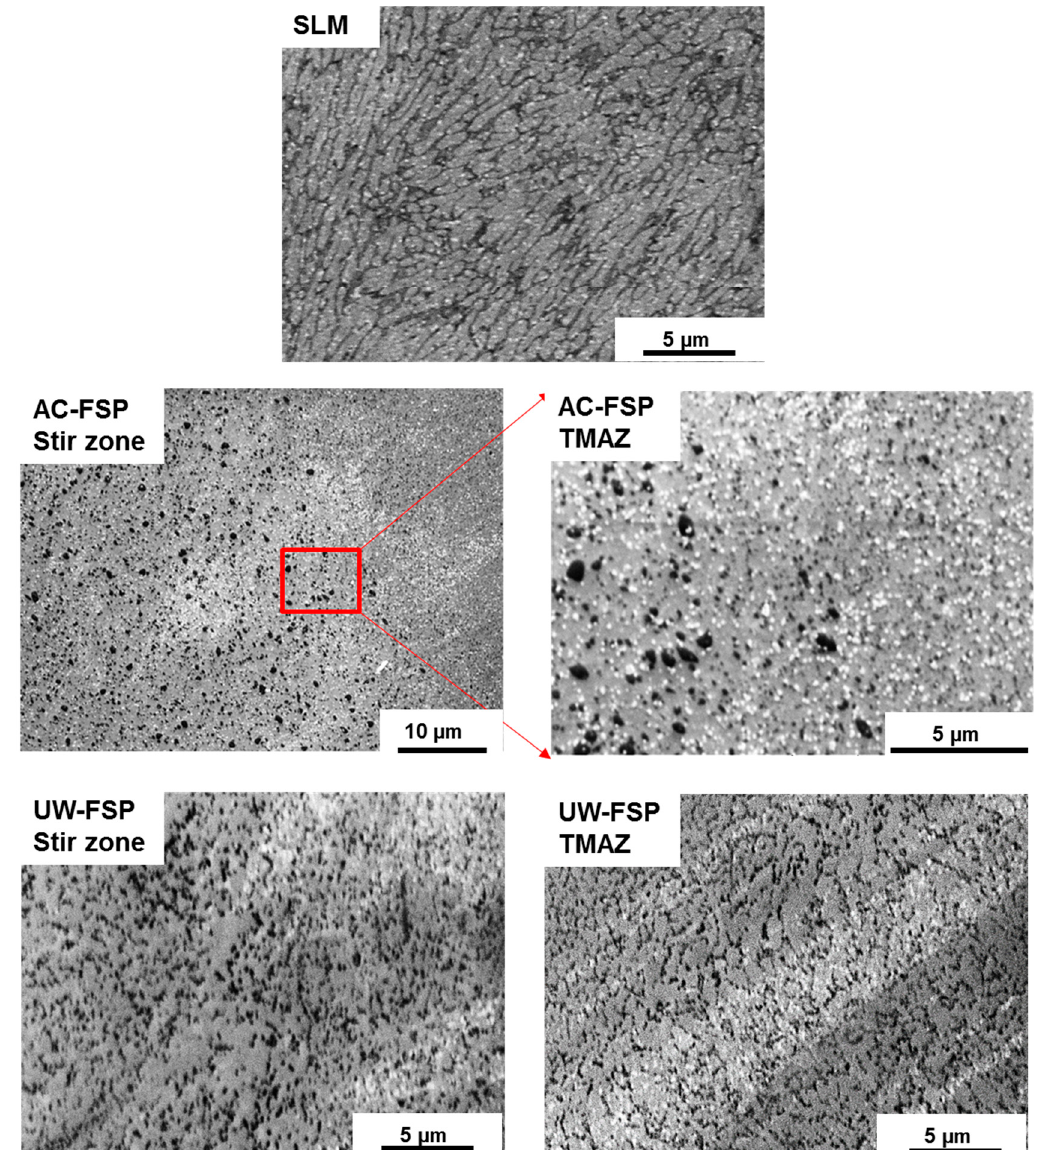
Figure 1. Micrographs (SE contrast) of SLM, AC-FSP and UW-FSP samples.